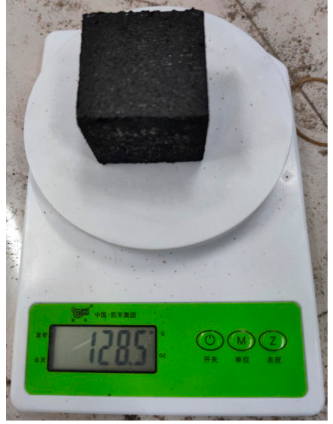
Figure 3. Mass of the specimens.